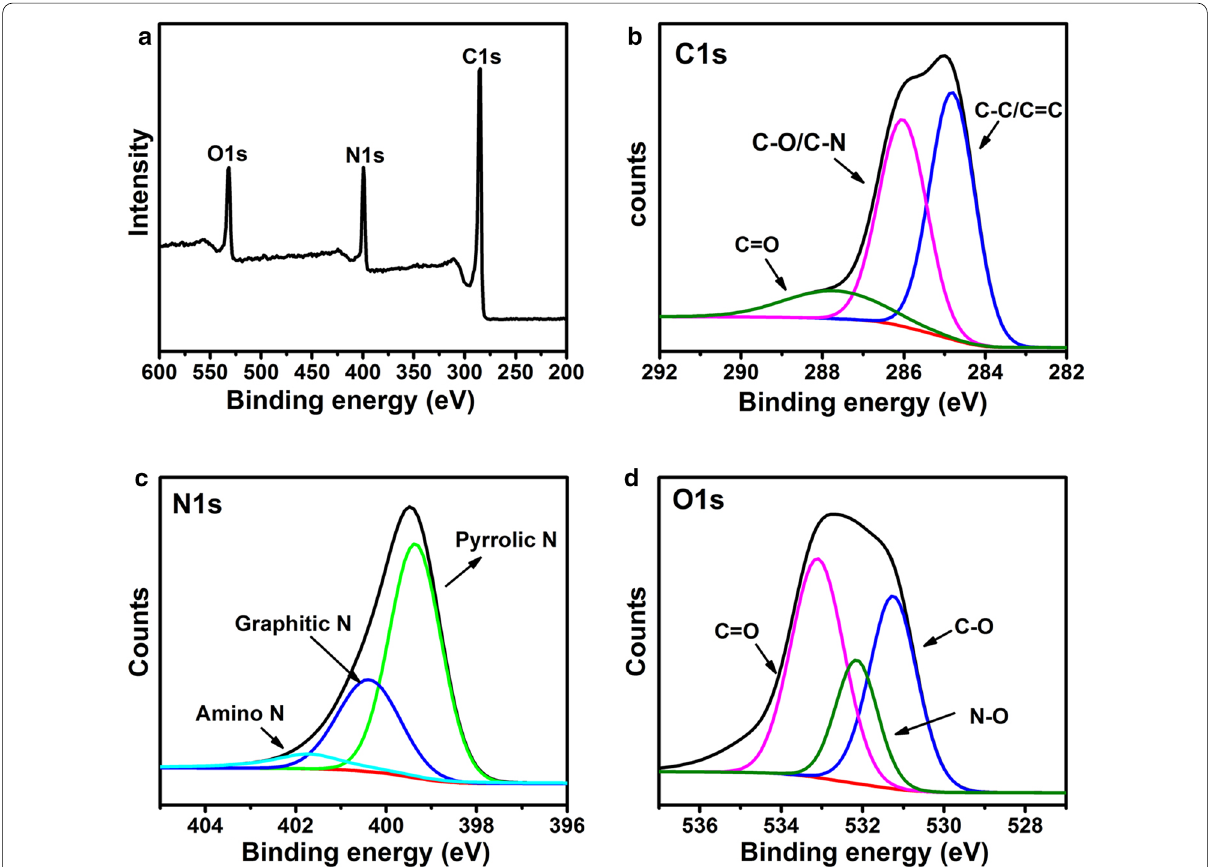
Fig. 2 XPS spectra of CQDs. A Full-scale XPS spectra of the CQDs; B High-resolution of C 1 s spectrum; C high-resolution of N 1 s spectrum; D High-resolution of O 1 s